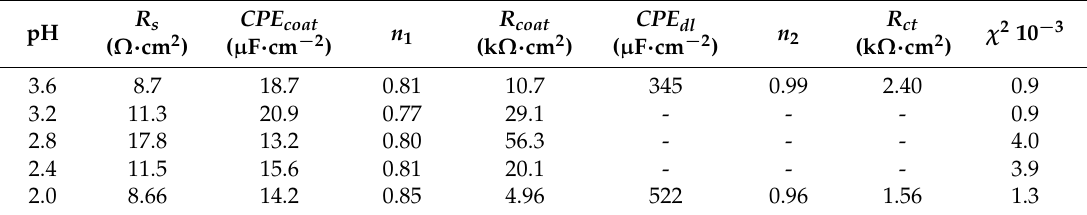
Figure 7. Experimental Nyquist plots of conversion coatings obtained from different stirring rates of Ca-P solution.